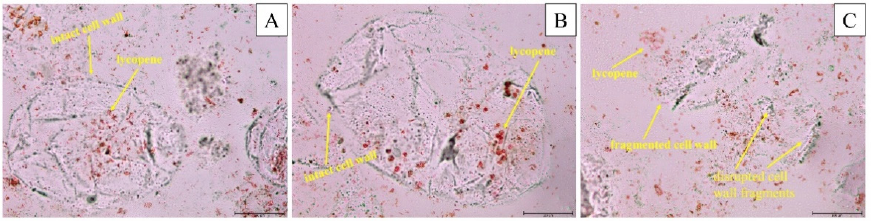
Figure 4. Microstructure of traditional tomato vinegar ( A ), pasteurized tomato vinegar ( B ) and ultrasound-treated tomato vinegar ( C ).